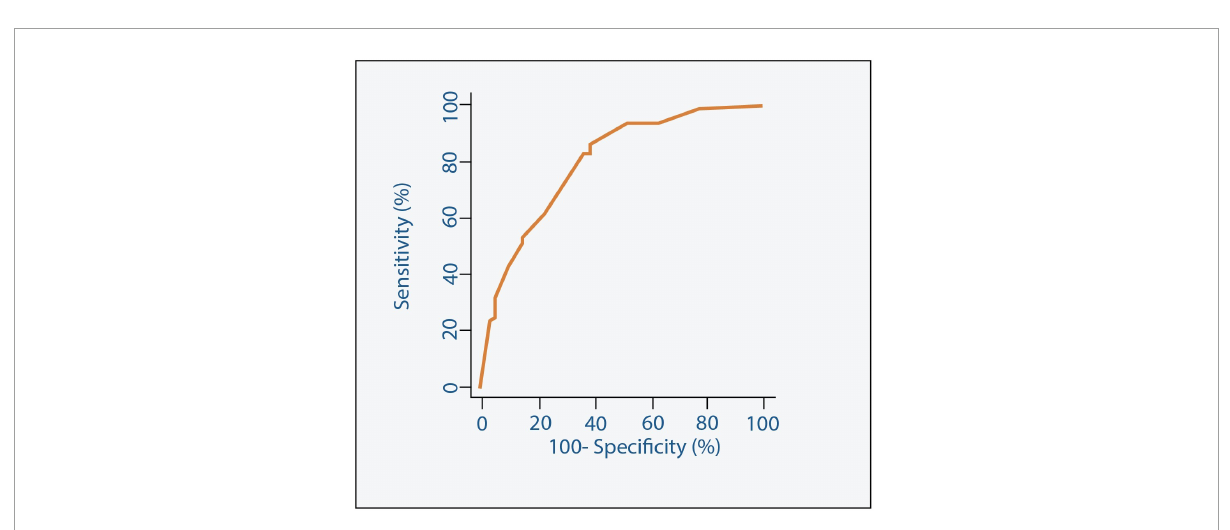
FIGURE4 Receiver Operating Characteristic (ROC) curve along with the Area Under the ROC curve (AUC) for the model predicting 30-day